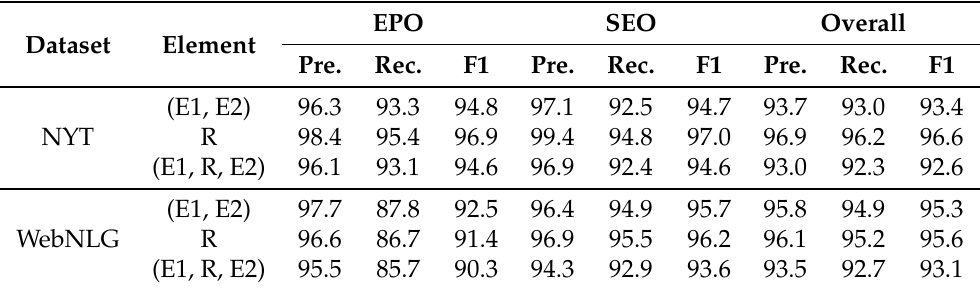
Table 6. Results on triple elements. The triple (E1, R, E2 ) is divided into (E1, E2) and R, where E1 represents the head entity, E2 represents the tail entity, and R represents the relation between E1, E2. Dataset